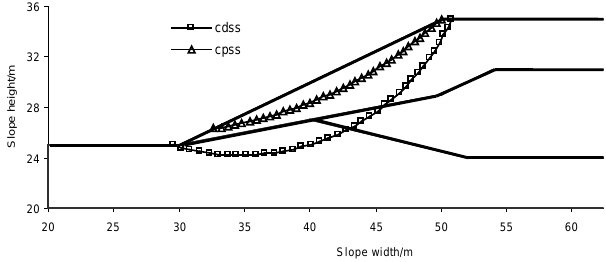
Figure 13. Cross section of the heterogeneous slope in example